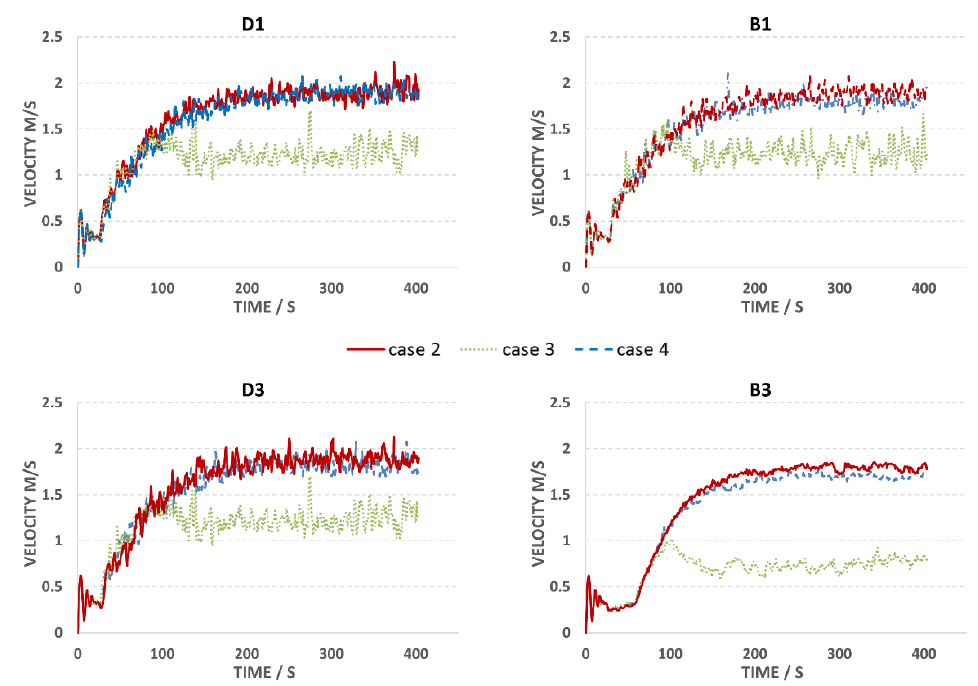
Figure 10. Pressure contour of 2 m (case 3), 4 m (case 2), and 6 m (case 4) smoke curtain case at times: 100 s, 300 s, and 700 s.